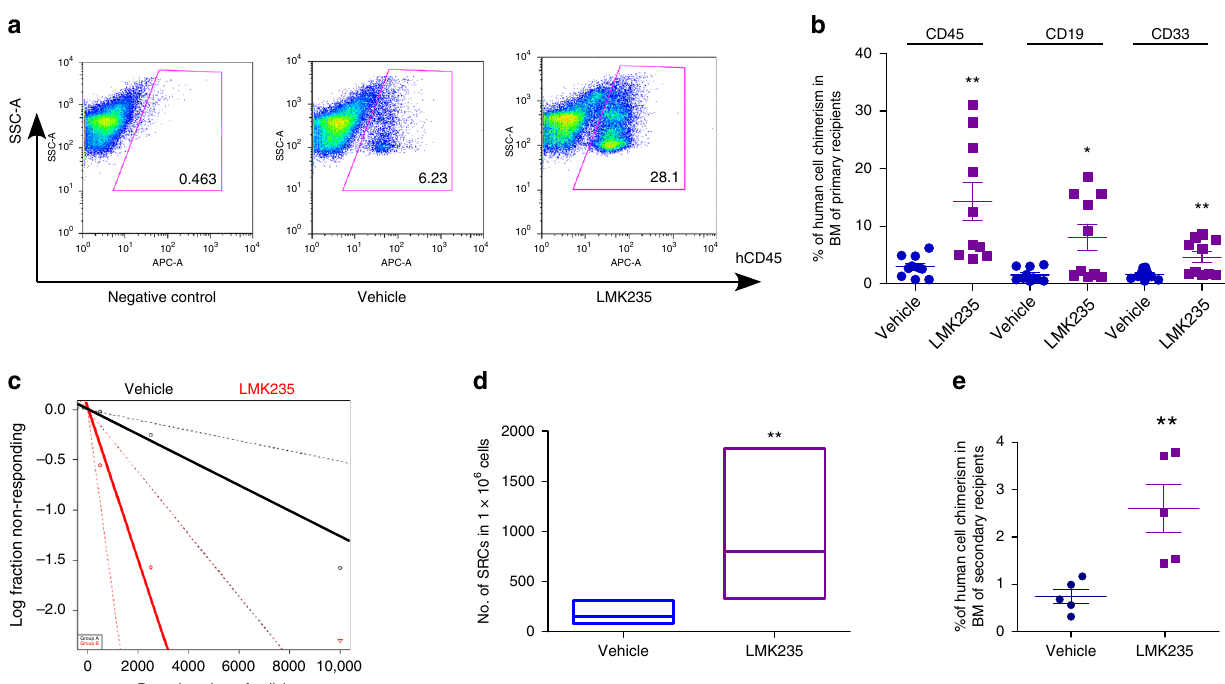
Fig. 4 Inhibition of HDAC5 increases long-term engraftment of human CB HSC. a Representative fl ow cytometric analysis of human engraftment in the BM of NSG mice, 16 weeks after transplantation. Left is from a mouse without transplantation (negative control), center and right are from mice transplanted with human CB CD34 + cells treated with vehicle control or LMK235 for 16 h. Human engraftment was assessed as the percentage of human CD45 + cells. b The percentage of human CD45 + cells, B-cell (CD19 + ), and myeloid cell (CD33 + ) chimerism in the BM of NSG mice after transplantation with 10,000 CB CD34 + cells that had been treated with vehicle or LMK235. The data were pooled from two independent experiments ( n = 10 mice per group, t -test, * p < 0.05. ** p < 0.01). c , d The frequency of human SRCs in CB CD34 + cells treated with vehicle control or LMK235. c Poisson statistical analysis of data from Supplementary Table 3. n = 30 mice in total. Shapes represent the percentage of negative mice for each dose of cells. Solid lines indicate the best- fi t linear model for each data set. Dotted lines represent 95% con fi dence intervals. d HSC frequencies (line in the box) and 95% con fi dence intervals (box) presented as the number of SRCs in 1 × 10 6 CD34 + cells. ** p < 0.01. e Human CD45 + cell chimerism in the BM of secondary recipient NSG mice at 16 weeks, which had been transplanted with 5 × 10 6 BM cells from primary recipient NSG mice ( n = 5 mice per group, t -test, ** p < 0.01). For all panels, data are shown as dot plots (mean ±